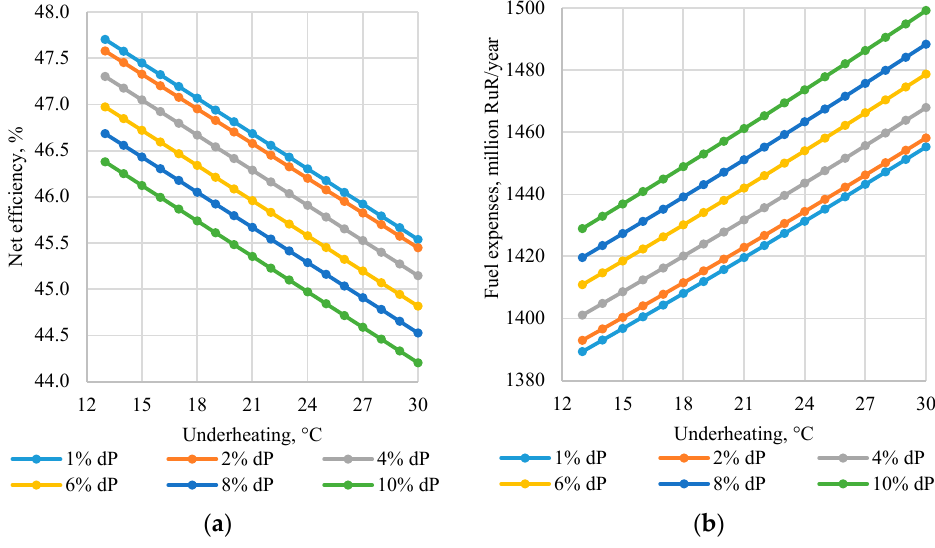
Figure 12. Underheating vs.: ( a ) net efficiency, ( b ) fuel expenses.